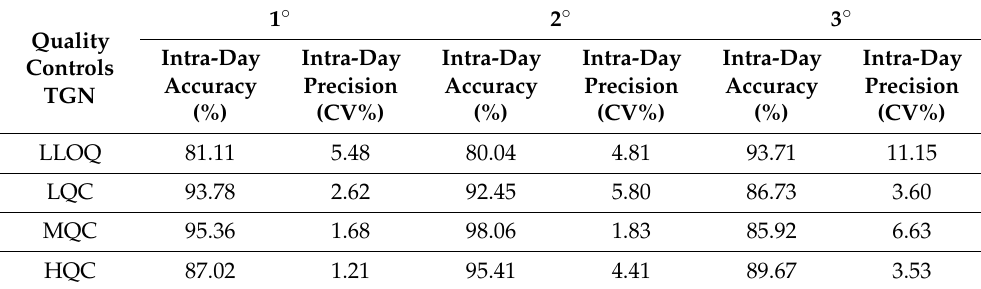
Table 6. Intra-day accuracy and precision (CV%) referred to QCs of TGN.